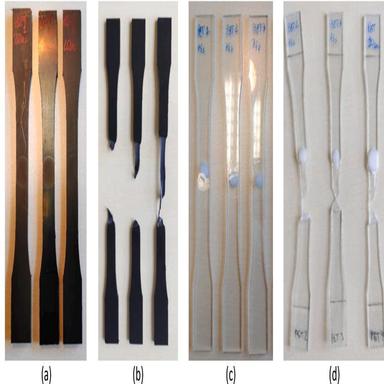
HDPE (a,b) and PET (c,d) samples after laser irradiation, before (a,c) and after (b,d) the tensile test.